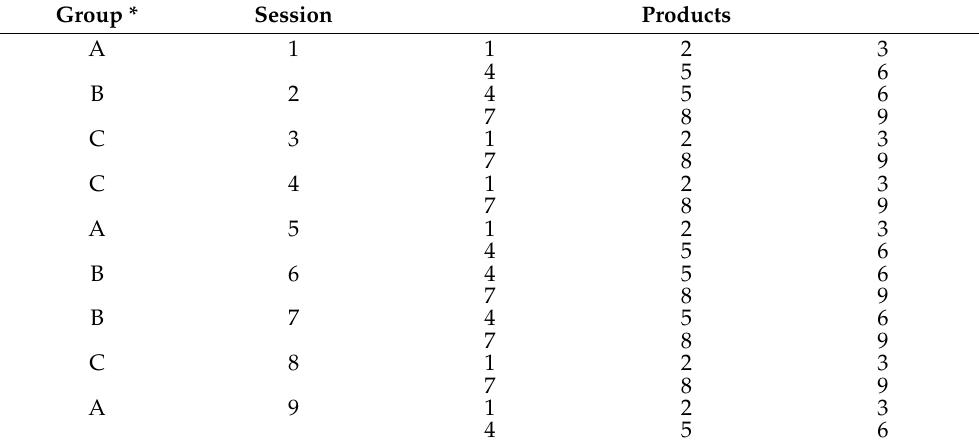
Table 2. Balanced incomplete block design for breast samples tested with consumers (Product 1: